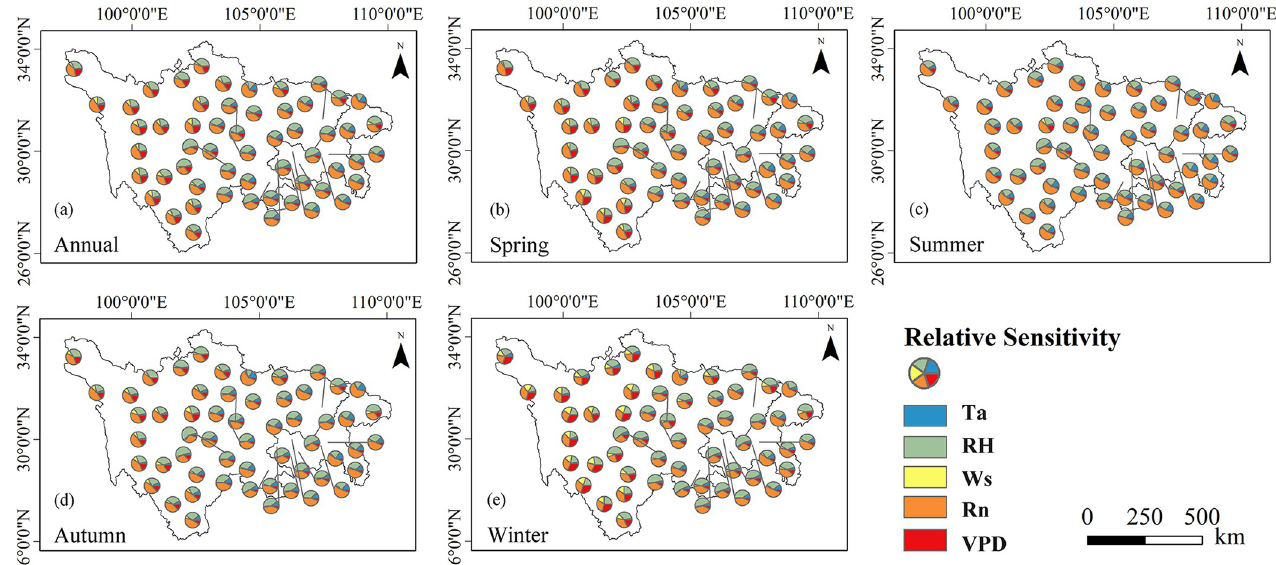
Fig 11. The relative sensitivity of the PET to air temperature (T a ), vapor pressure deficit (VPD), net radiation (R n ), relative humidity (RH) and wind speed (W s ) in annual (a), spring (b), summer (c), autumn (d) and winter (e) during 1970–2020 at 56 stations.